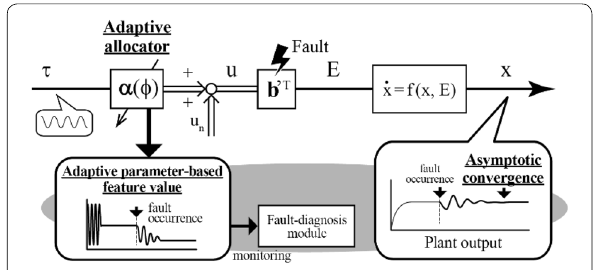
Fig. 2 Proposed active fault diagnosis and fault-tolerant control with adaptive test signal